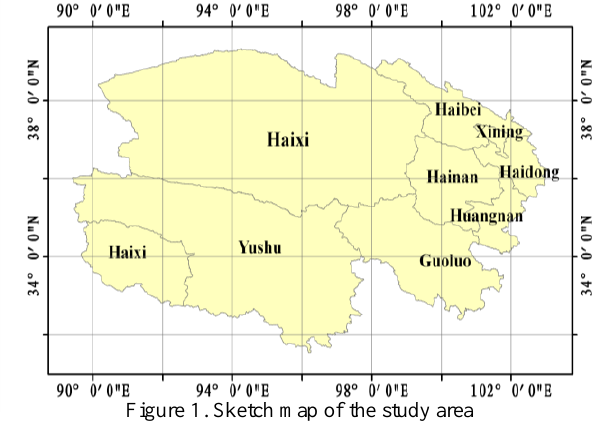
Figure 1. Sketch map of the study area